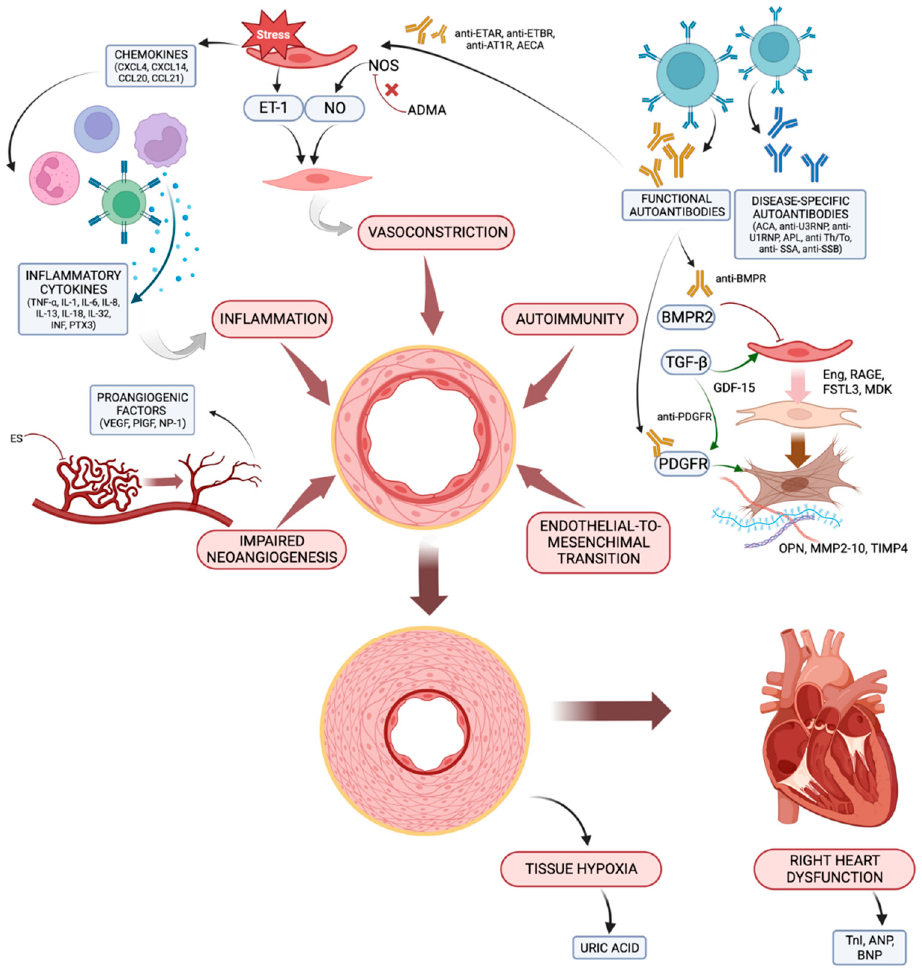
Figure 1. The main pathogenetic mechanisms leading to CTD-PAH and the associated biomarkers. ACA, anti-centromere antibodies; ADMA, asymmetric dimethylarginine; AECA, anti-endothelial cells antibodies; aPL, antiphospholipid antibodies; ANP, atrial natriuretic peptide; AT1R, angiotensin receptor type 1; BMPR, bone morphogenic protein receptor; BNP, brain natriuretic peptide; CCL, C-C motif ligand; CXCL, C-X-C motif ligand; Eng, endoglin; ES, endostatin; ET-1, endothelin-1; ETAR, endothelin receptor type A; ETBR, endothelin receptor type B; FSTL-3, follistatin-like 3; GDF-15, growth differentiation factor-15; IL, interleukin; IFN, interferon; MDK, midkine; MMP, matrix metalloproteinase; NO, nitric oxide; NP-1, neuropilin-1; OPN, osteopontin; PDGFR, placental derived growth factor receptor; PlGF, placental growth factor; PTX3, pentraxin 3; RAGE, receptor for advanced glycation end products; RNP, ribonucleoprotein; TIMP, tissue inhibitor of metalloproteinase; TNF, TnI, troponin I; tumour necrosis factor; VEGF, vascular endothelial growth factor. Created with BioRender.com.